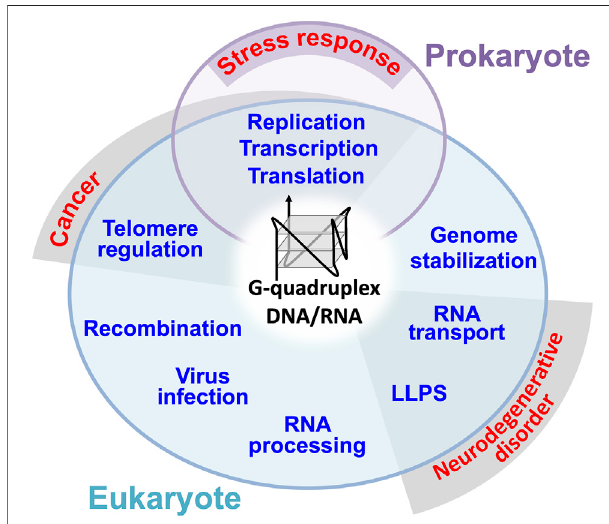
FIGURE 1 | General roles of DNA/RNA G4s in prokaryote and eukaryote. G4 has also been suggested to be involved in prokaryotic stress responses through replication, transcription, and translation. Dysregulation of telomere regulation, transcription, translation and replication by G4 are suggested to be involved in the pathogenic mechanism of human cancer. Mutations in G4 containing RNAs and G4 binding proteins involved in RNA transport and LLPS have been found in patients with neurodegenerative diseases such as